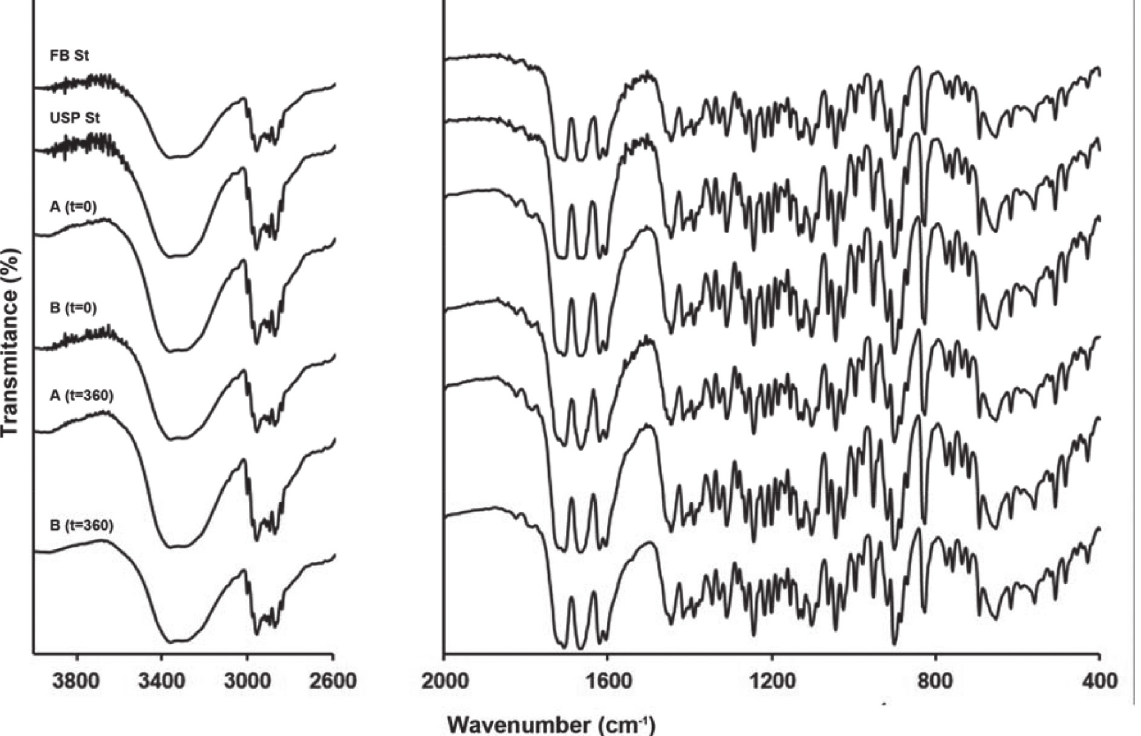
FIGURE 4 - Fourier transform infrared spectroscopy (FTIR) of prednisone samples A and B at zero and 360 days of the stability study and the USP (USP St) and Brazilian Pharmacopoeia (FB St)